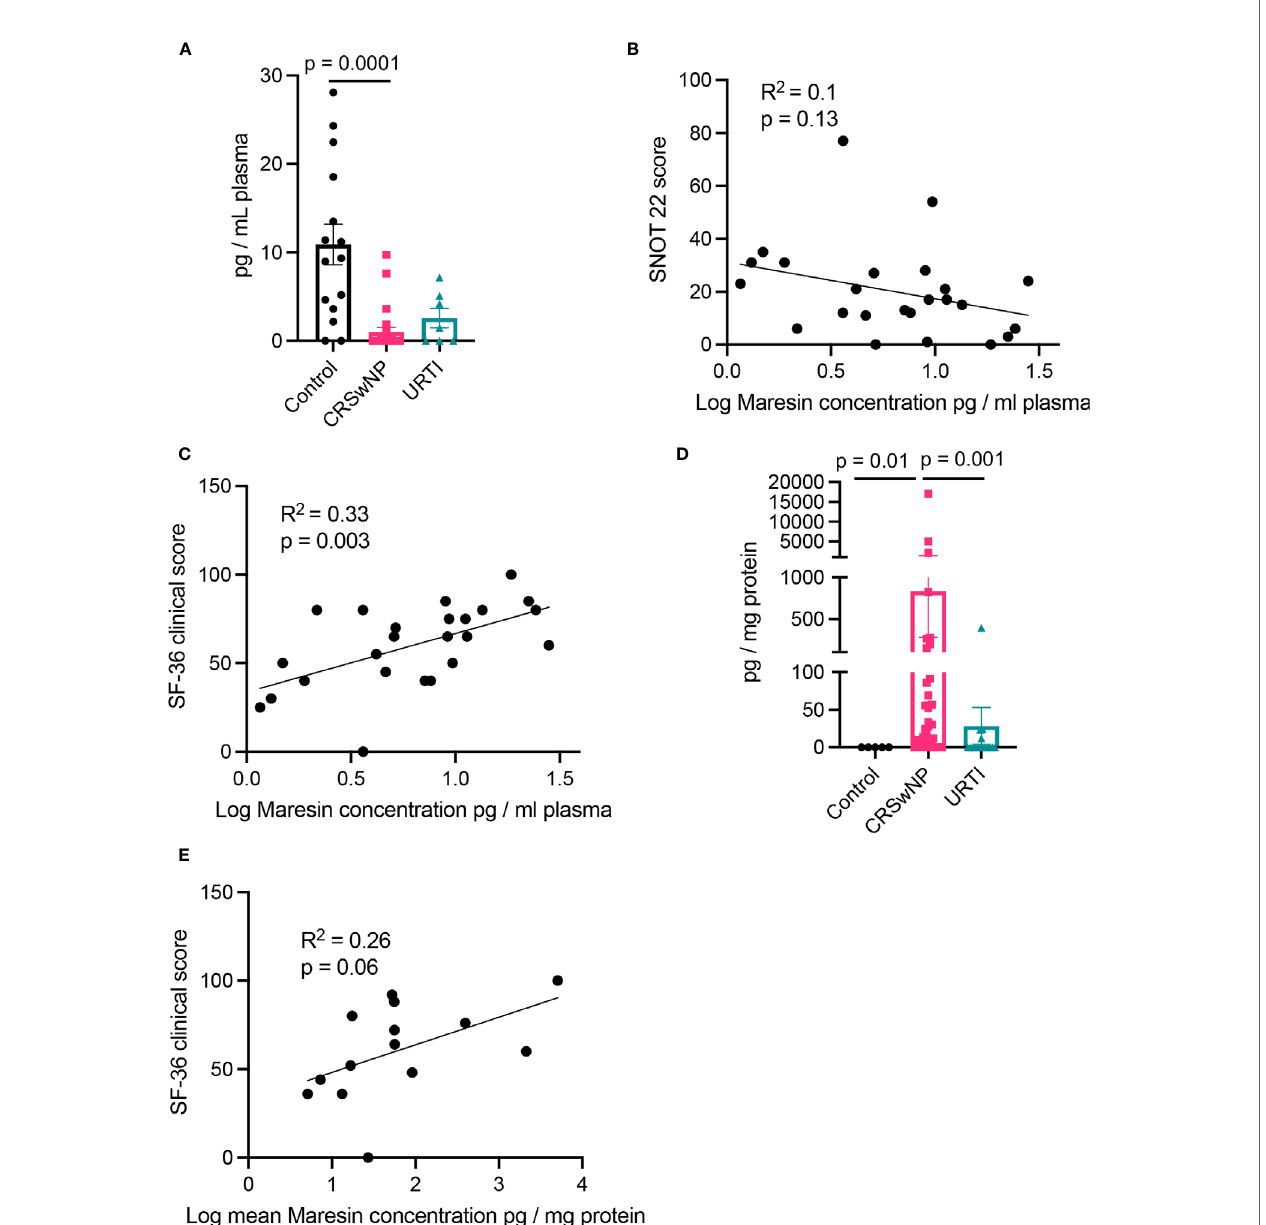
FIGURE 2 | Plasma Maresin levels correlate with clinical scores. (A) Plasma Maresin levels (i.e., sum of MaR1, 7S,14S-diHDHA, MaR2, 22-OH-MaR1, 22-COOH- MaR1, 14-oxo-MaR1, 4,14-diHDHA, MaR1 n-3 DPA , MaR2 n-3 DPA and 7S,14S-diHDPA) for healthy volunteers (n = 15), CRSwNP (n = 24), URTI (n = 8) patients. (B, C) Linear regression analysis of Maresins levels in plasma in relation to (B) SNOT 22 scores (C) 36-Item Short Form Health Survey general health measures. (D) Maresin concentrations in nasal secretions. (E) Linear regression analysis of Maresins levels in plasma in relation to 36-Item Short Form Health Survey general health measures. (A, D) Kruskal-Wallis test used to identify differences between the mean ranks of at least one pair of the groups. Dunn ’ s pairwise tests was carried out to identify differences between group